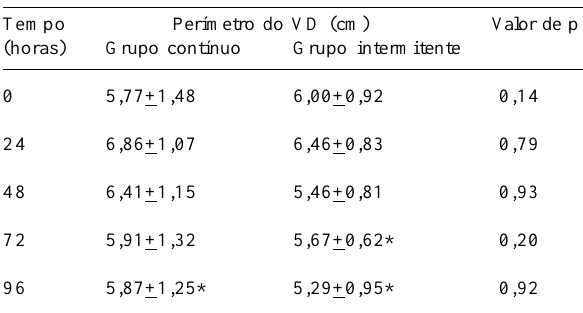
Tabela 2. Perímetro do VD medido pelo ecocardiograma na altura dos vasos da base (grupos de sobrecarga sistólica contínua x intermitente).